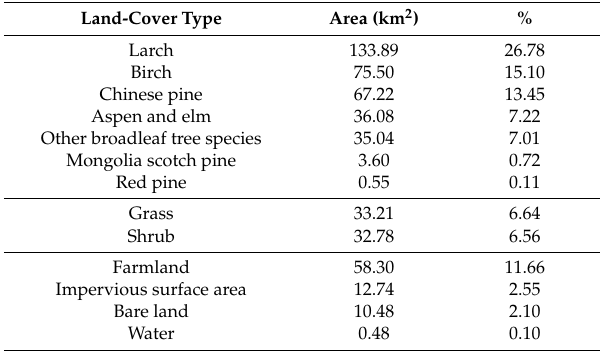
Table 7. Area of all land-cover types in this study.